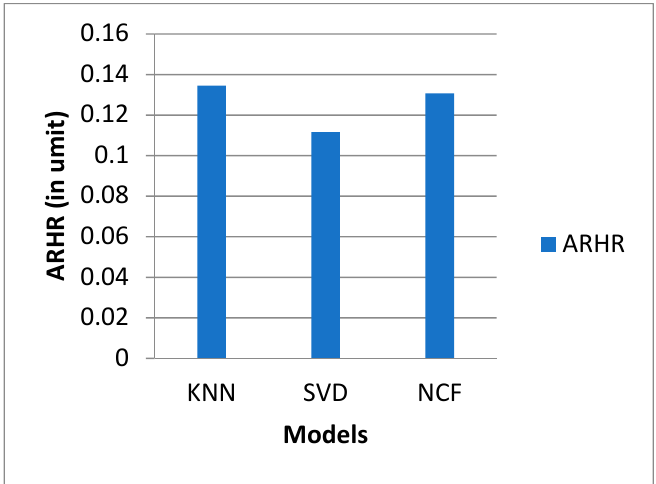
Figure 7. Performance results of different models in terms of ARHR in 60:40 training–testing scenario.